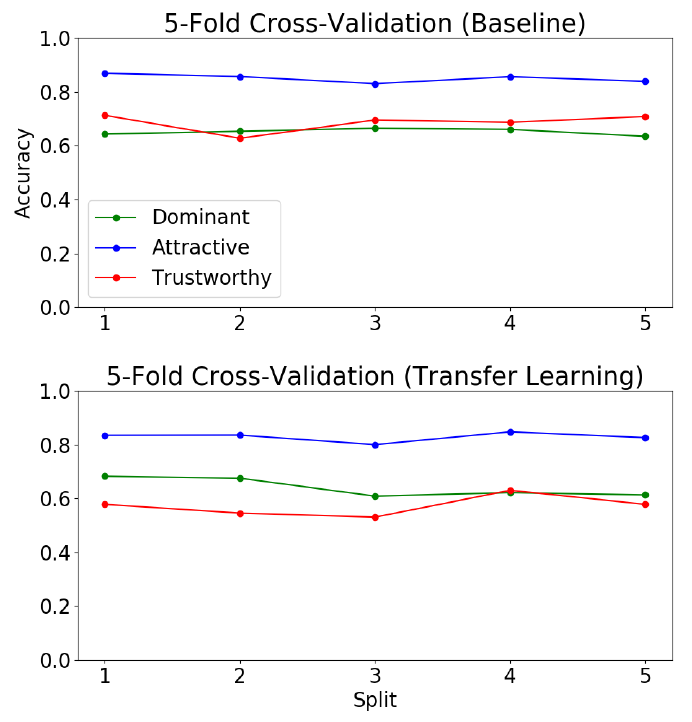
Figure 6. Five-fold cross-validation on baseline multi-label classification model vs. transfer learning multi-label classification